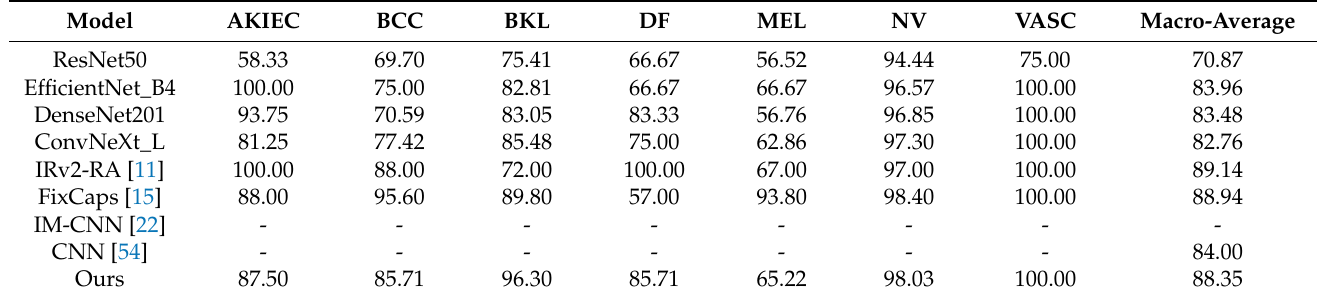
Table 6. The precision of each model on the public dataset HAM10000 (test set of 828 images); the missing values of indicators are replaced by “-”, and the unit is %.